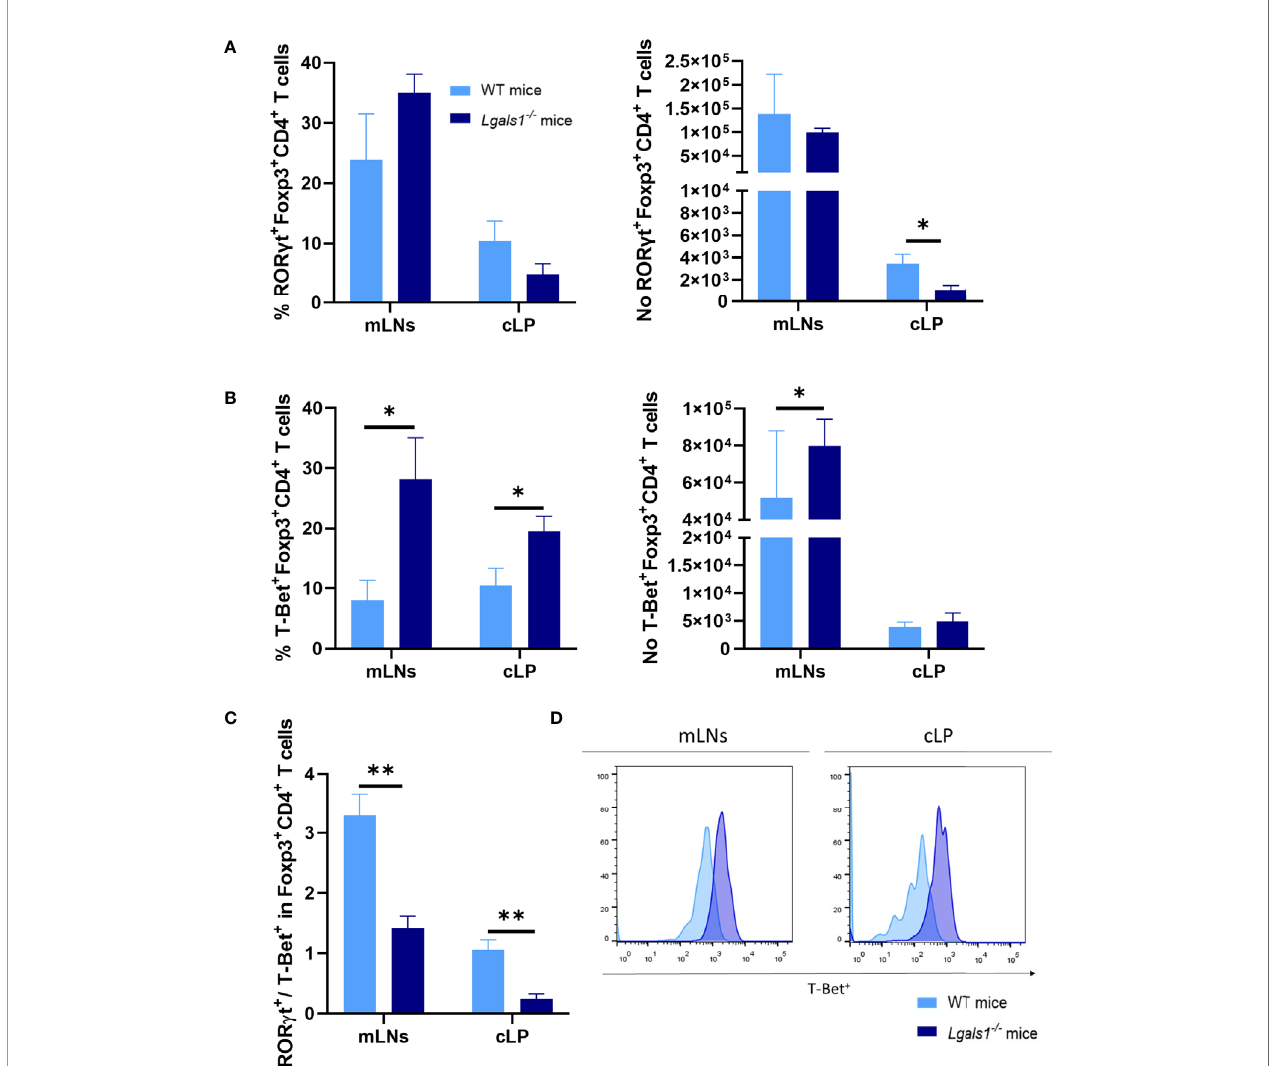
FIGURE 5 | Increase frequencies of T-Bet + Foxp3 + CD4 + regulatory T in the absence of endogenous galectin-1 during DSS-induced colitis. Flow cytometry was used to measure ROR g t and T-Bet frequencies in mLNs and cLP within the Foxp3 + CD4 + Treg cells. (A) Frequency of ROR g t + Foxp3 + CD4 + T cells and absolute numbers of ROR g t + Foxp3 + CD4 + T cells. (B) Frequency of T-Bet + Foxp3 + CD4 + T cells and absolute numbers of T-Bet + Foxp3 + CD4 + T cells. (C) ROR g t/T-Bet ratio in Foxp3 + within CD4 + T cells. (D) Representative histograms of T-Bet + expression in Foxp3 + CD4 + Treg cells by fl ow cytometry of mLNs and cLP in colitic mice (n = 8 for WT and, n = 6 for Lgals1 − / − mice per group). Data are representative of three independent experiments. Statistical analysis was done using Mann – Whitney U test. Data are shown as mean ± SEM, *p < 0.05 and **p <